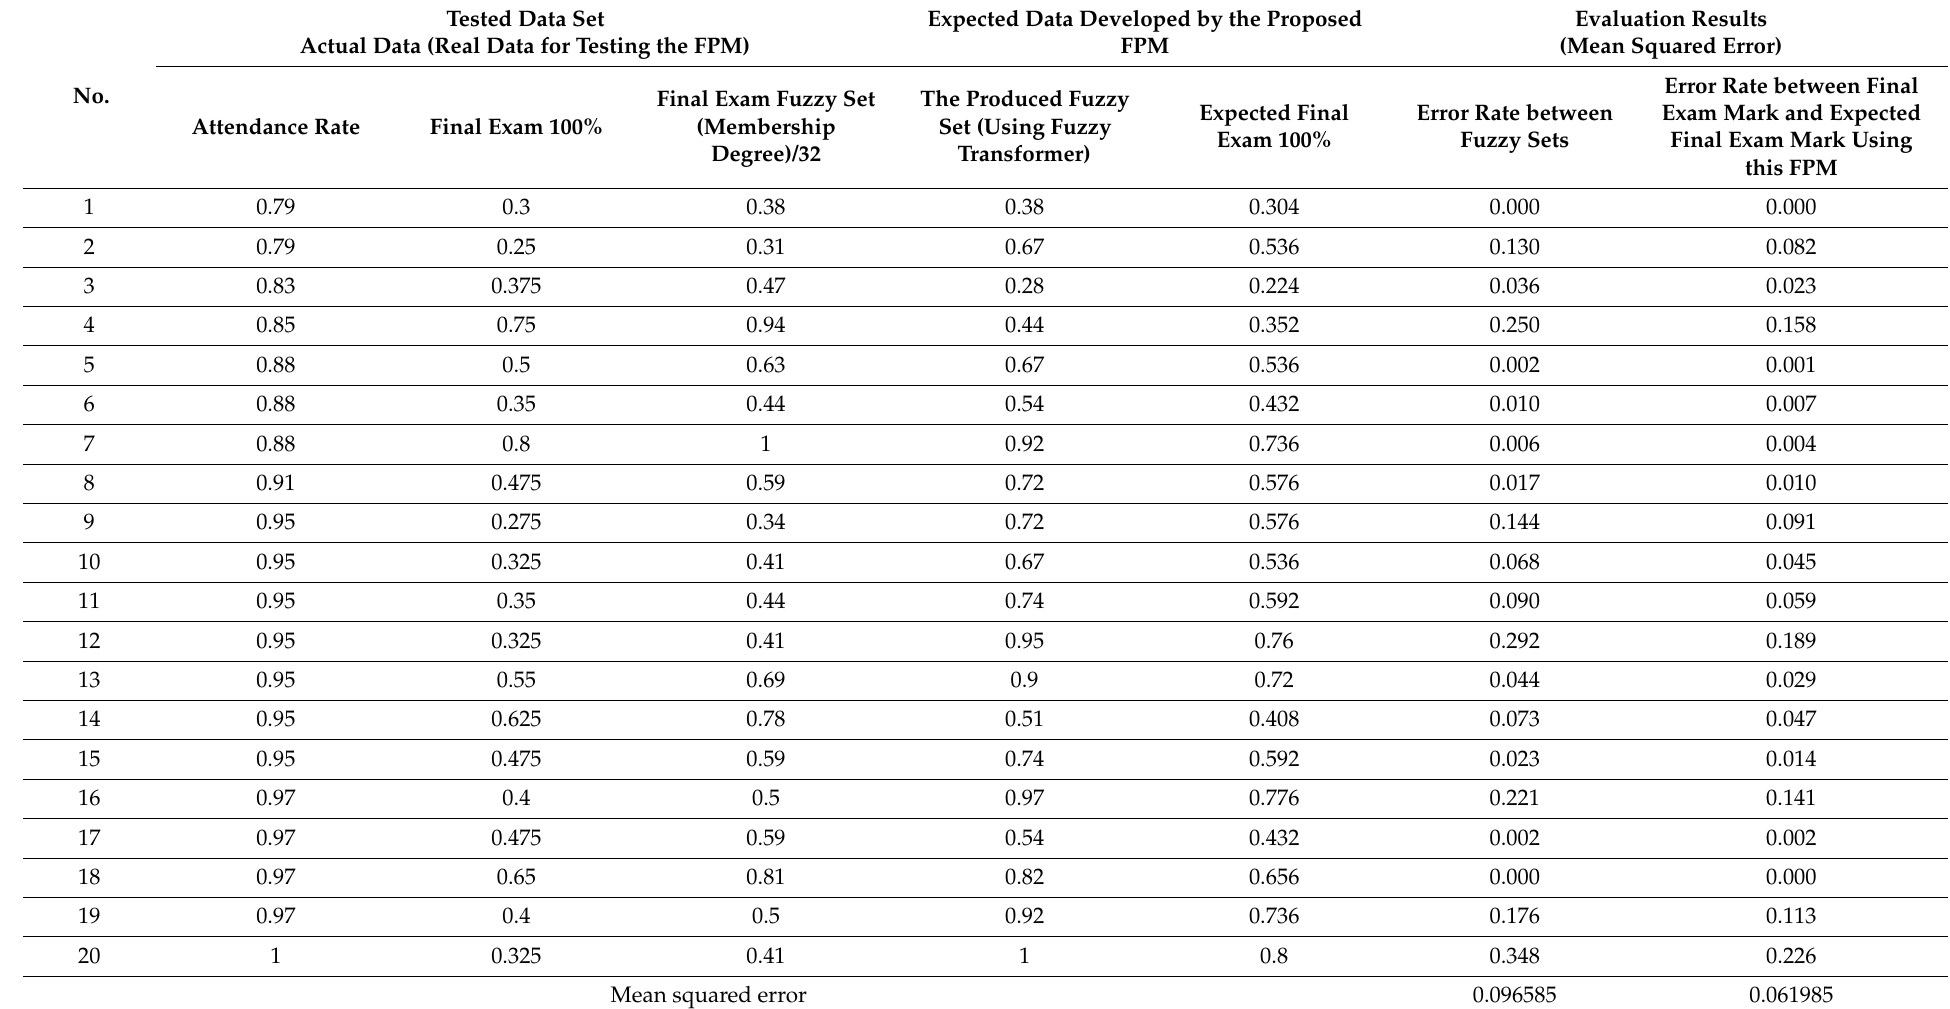
Table 3. The result of testing the FPM (main